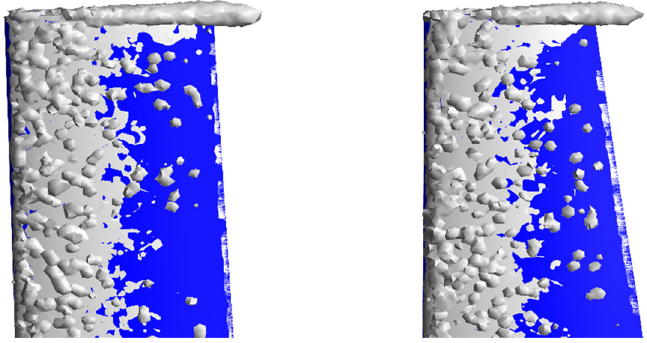
Figure 17. The tip vortices of the base ( left ) and designed ( right ) blades.